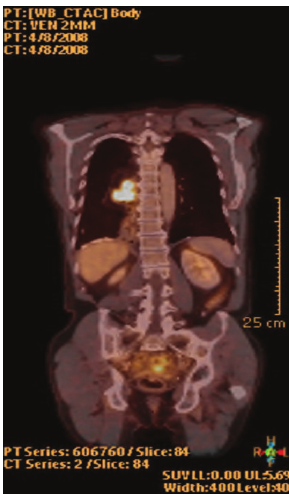
Figure 1: The PET-CT showed a tumor paravertebral right at the level of D7–D9 and no metastatic disease.